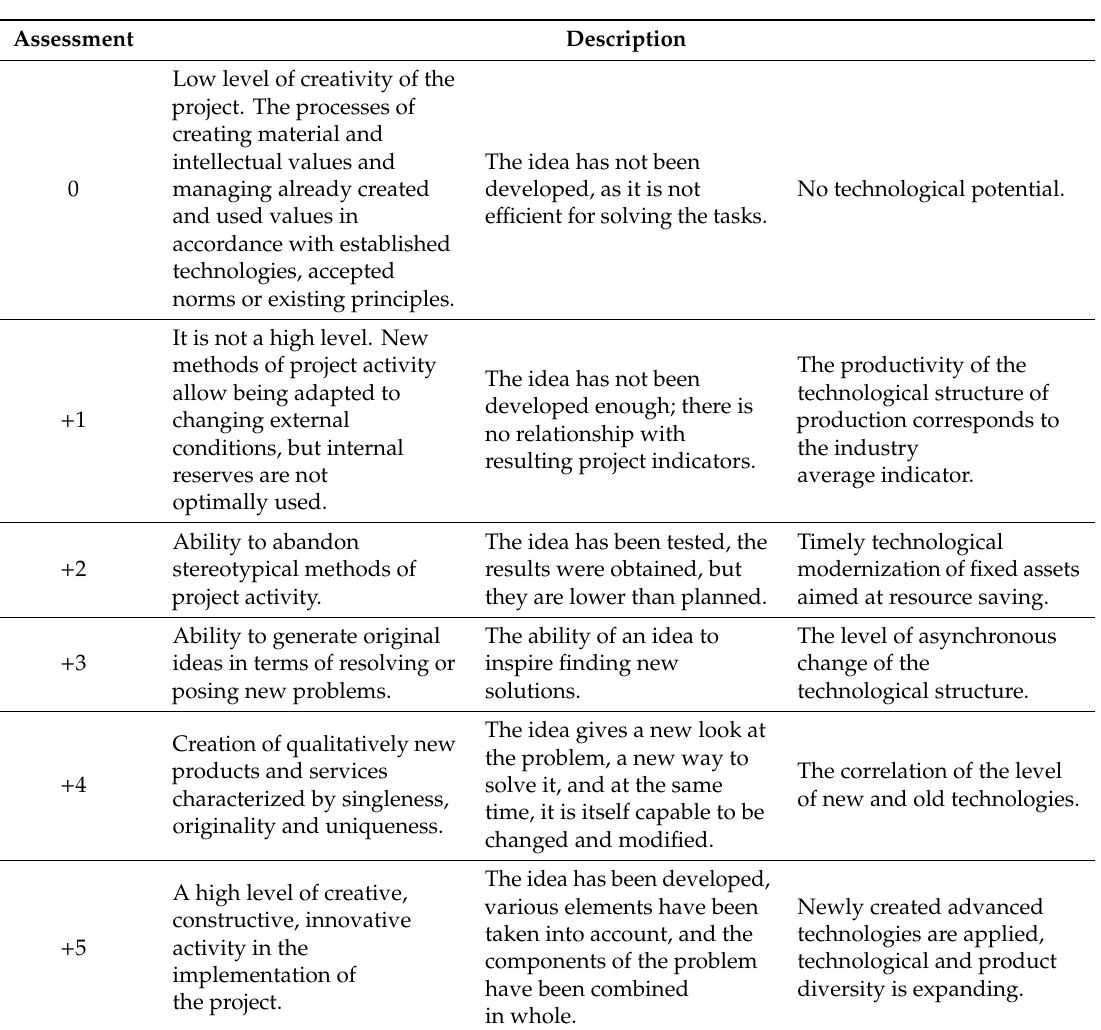
Table 2. Assessment scale of qualitative indicators of the project potential (compiled by the authors on the basis of [19].